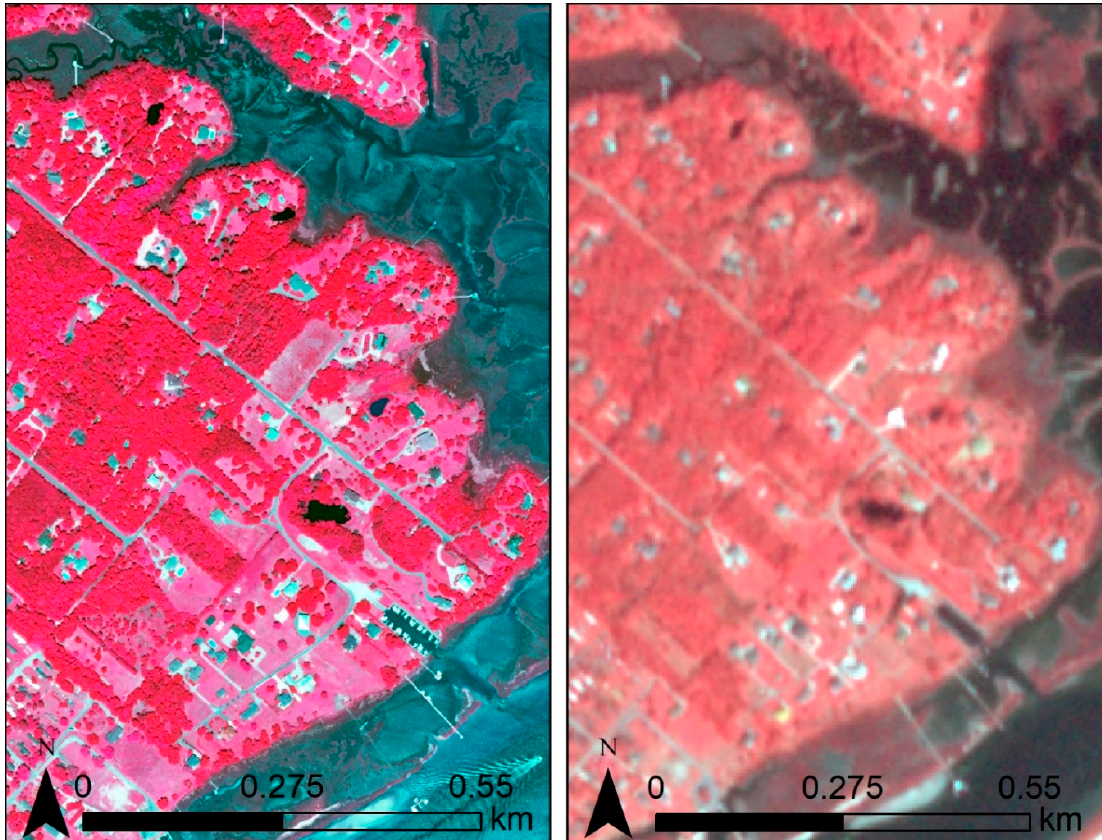
Figure 5. Example imagery from the National Agriculture Imagery Program (NAIP) (left) and PlanetScope imagery from Planet (right) for a portion of coastal Pender County.